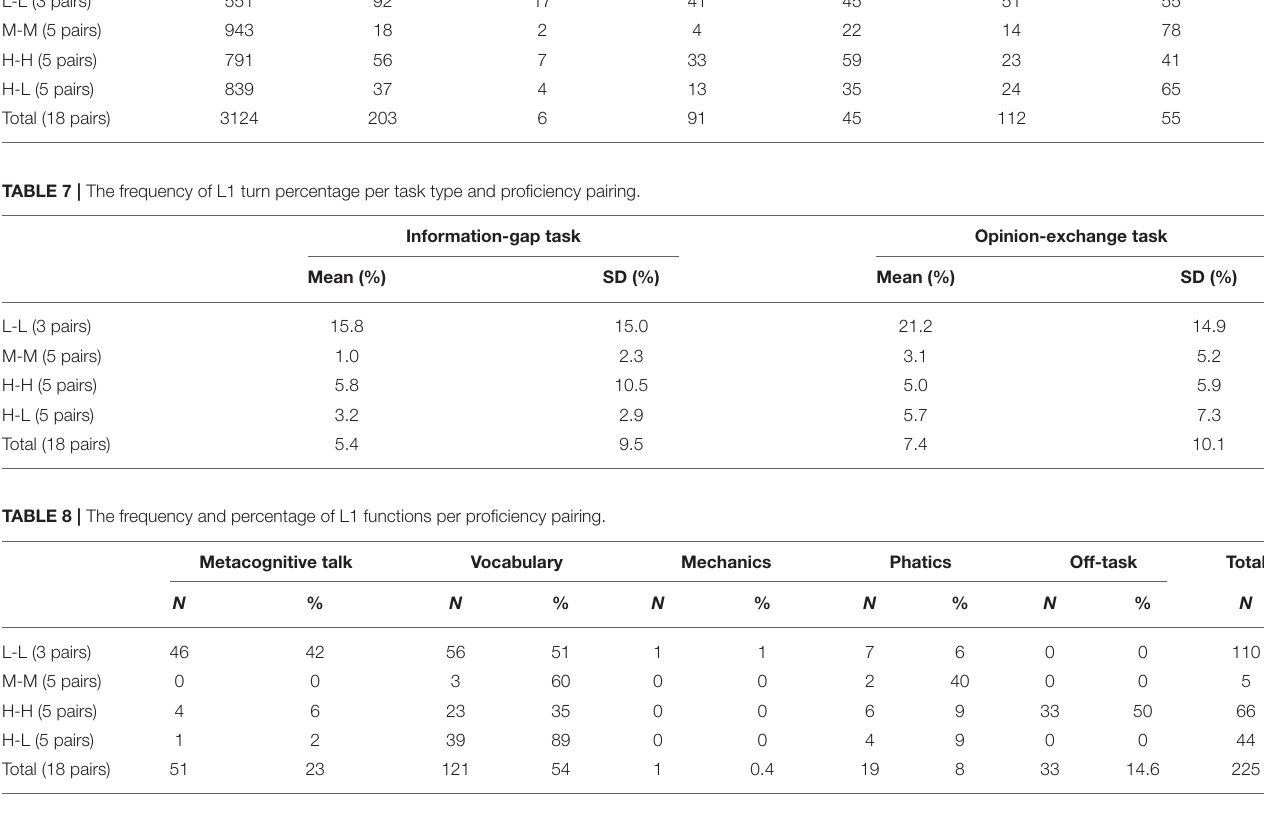
TABLE 9 | The frequency and percentage of L1 functions per task